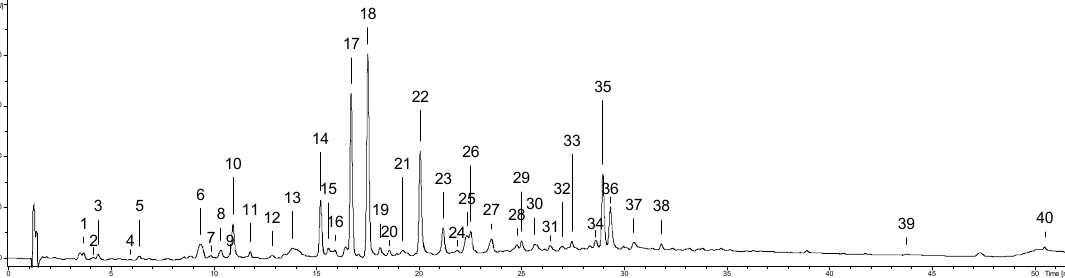
Figure 1. Representative UHPLC-PDA chromatogram of AE at 280 nm. The peak numbers refer to those implemented in Table S1.